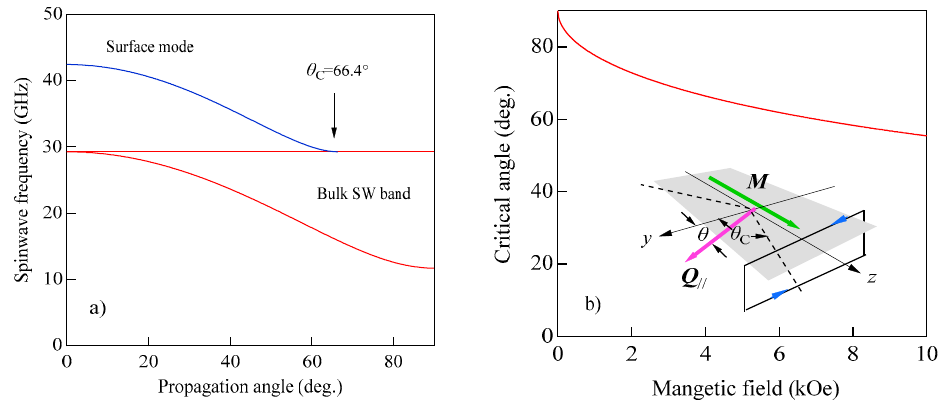
Figure 4. ( a ) Propagation angle development of the bulk SW band ( − ) and the DE mode frequency ( − ). We used the following set of magnetic constants: g = 2.09, H = 4.0 kOe, and 4 π M = 21.0 kG. Here, the upper and lower bounds of the bulk SW band are displayed for clarity’s sake. ( b ) The magnetic field dependence of the critical angle θ C . The inset shows a schematic illustration of the nonreciprocal propagation characteristics of the DE mode. The critical angle is indicated by the broken lines. The allowed propagation direction of the DE mode localized on the top and bottom magnetic surfaces is indicated by the arrows on the